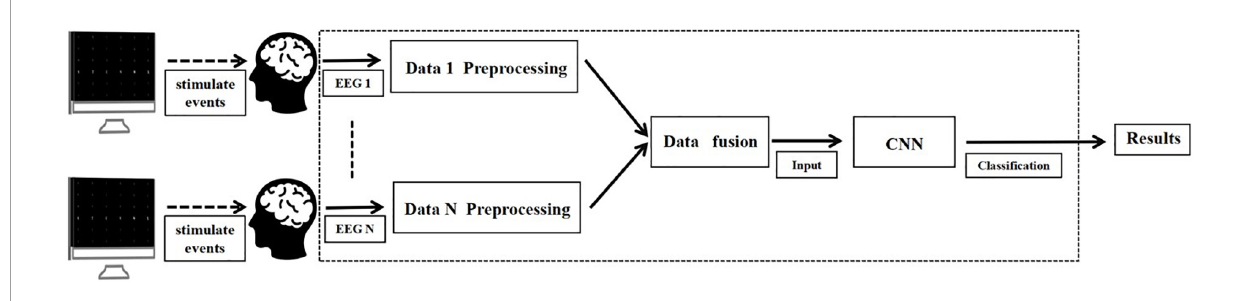
FIGURE1 Structure of centralized collaborative brain-computer interfaces (cBCI) system.